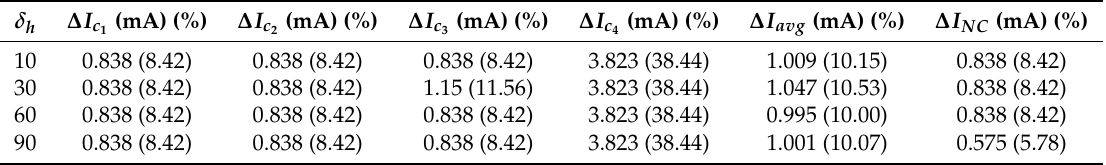
Table 4. Current reduction using the sensor selection method on the HET in mA and percent of total power usage reduction for the different values of δ h . The last column corresponds to not using clustering.